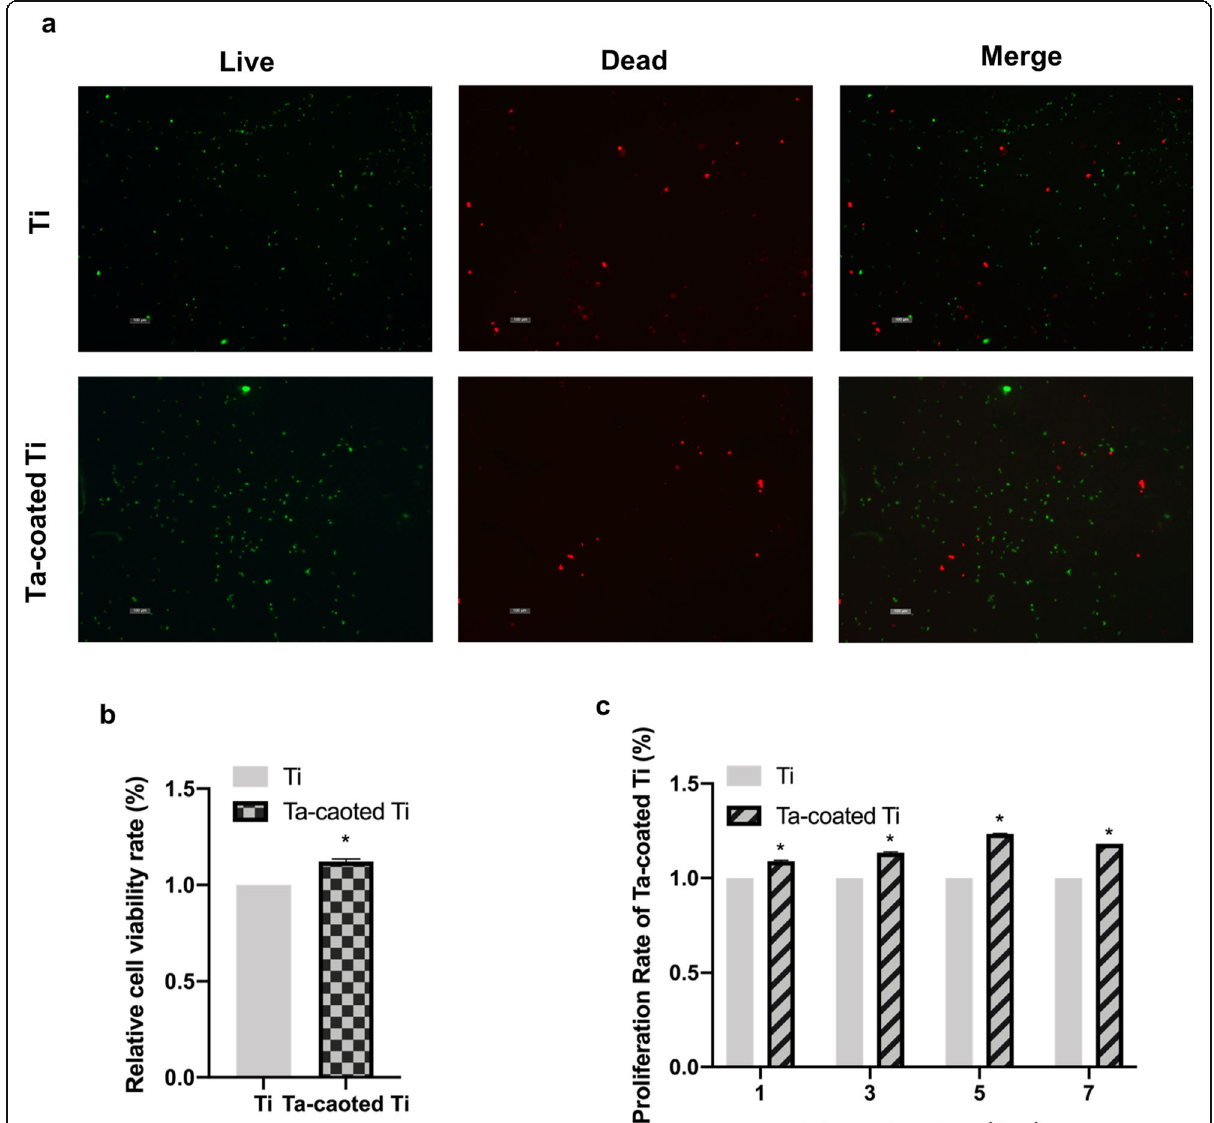
Fig. 4 Relative cell viability and proliferation assay. a HGFs cultured on both samples for 24 h were stained with Calcein AM (green) and PI (red), indicating live and dead cells (× 100). b Relative HGF viability rate was detected at 24h based on live/dead cell staining. * p < 0.001 when compared with Ti group. c Relative HGFs proliferation rate on both samples was detected by CCK-8 at 1, 3, 5, and 7 days. * p < 0.0001